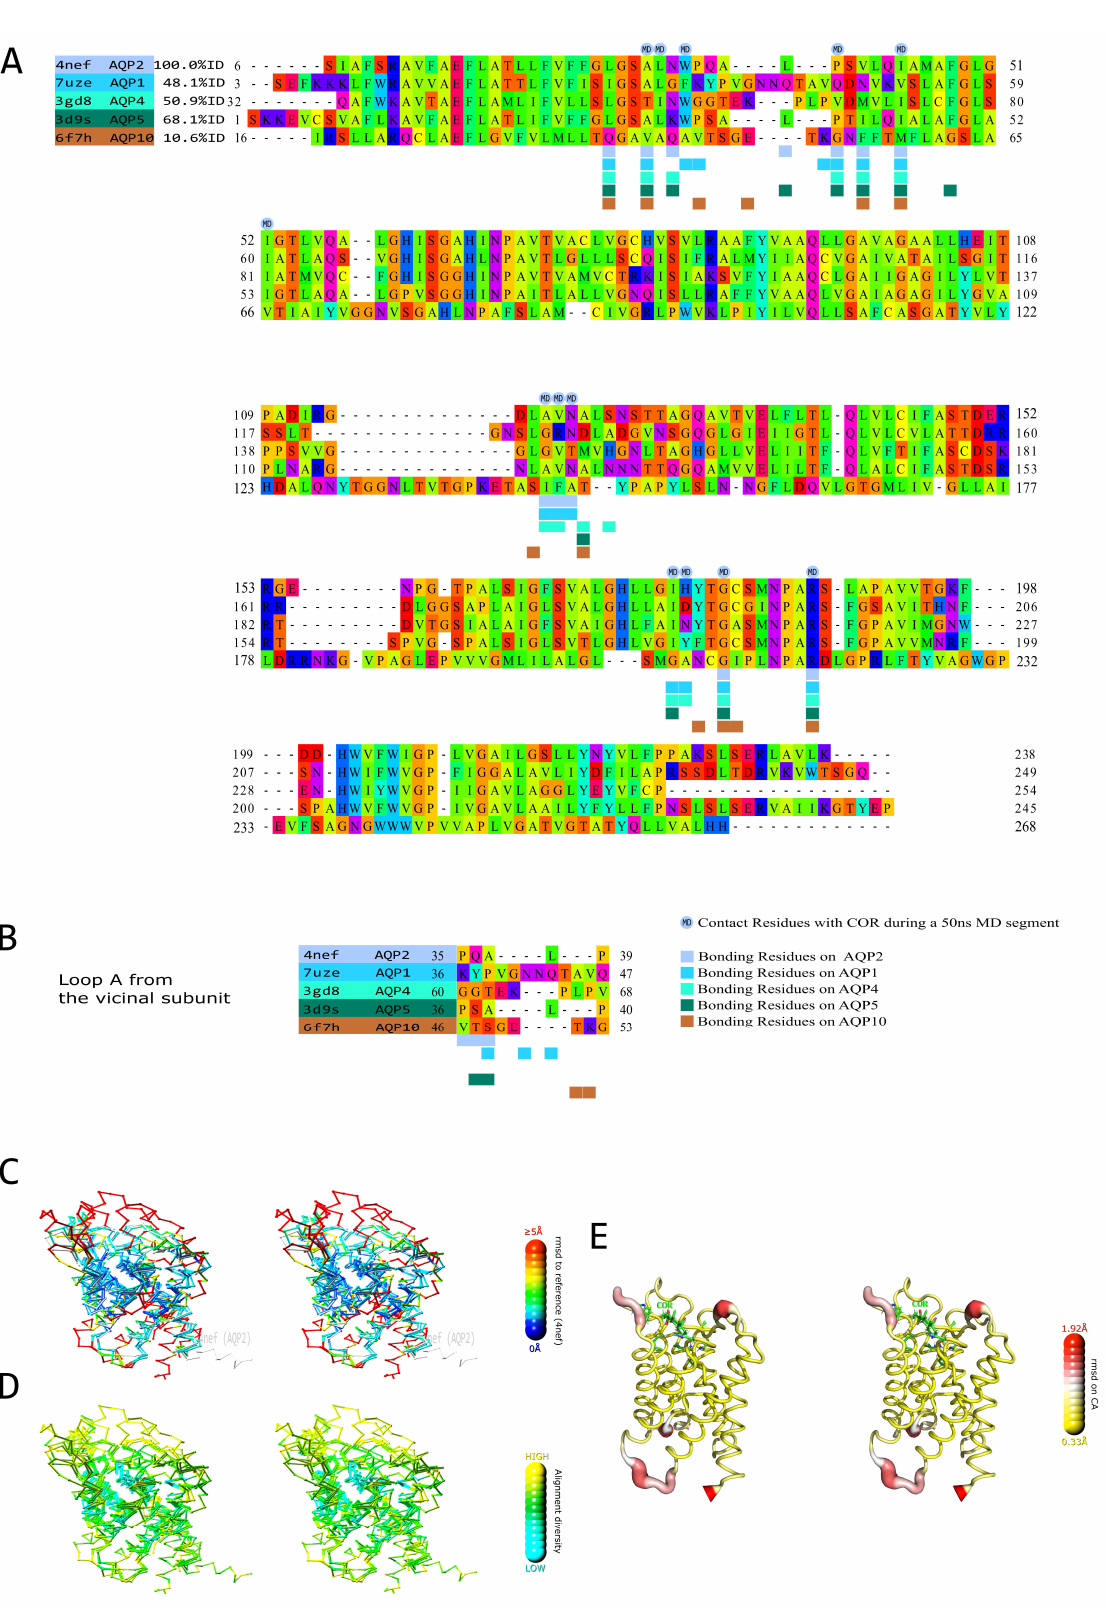
Figure 2. Structural alignment of experimentally solved structures of 4 different human AQP rep- resentatives against the structure of human AQP2. The PDB codes of the corresponding structures are recalled at the beginning of the alignment. The template to color the residues (Taylor Scheme) is meant to highlight the conversation of the physical–chemical properties. ( A ) Structural alignment